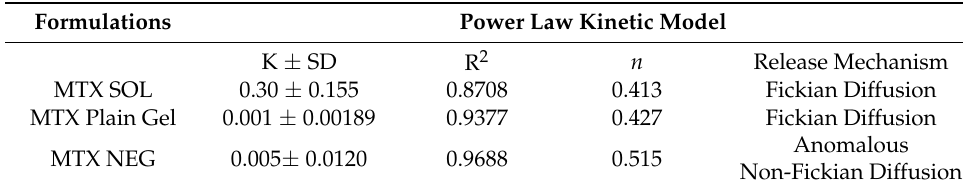
Table 5. Release kinetics of prepared formulations.